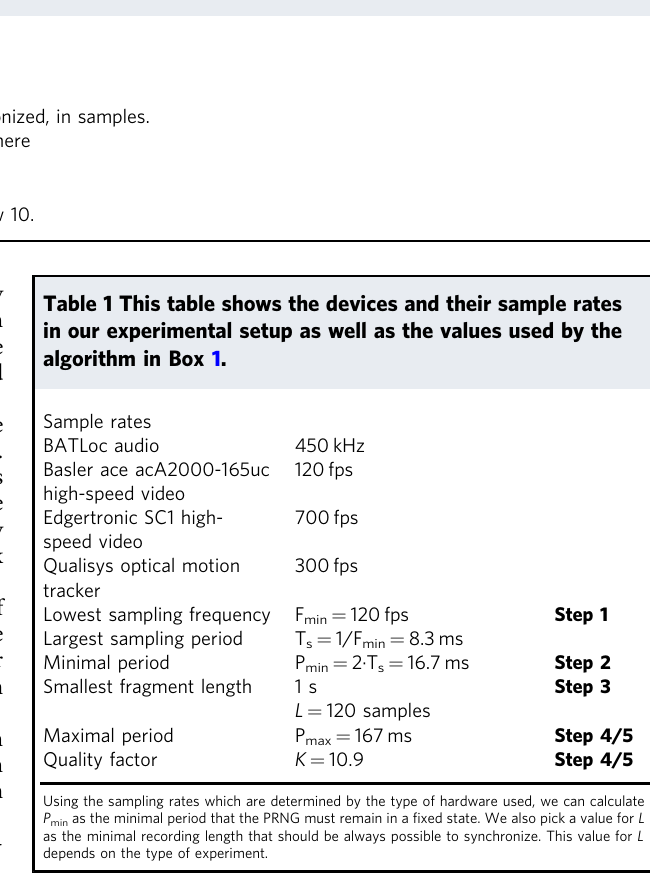
Box 1 | This algorithm describes the general procedure for fi nding parameters P max and P min re quired for the PRNG. The algorithm depends on the recording units and their relative sample rates. By selecting suitable values for the PRNG you ensure that all transitions are recorded by all recording units, thus ensuring synchronization will succeed